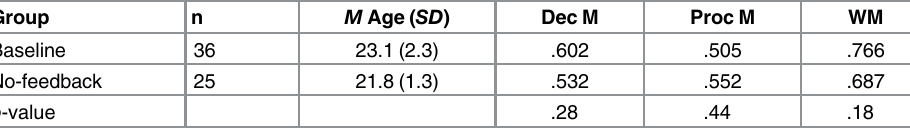
Table 3. Group sizes, mean ages, and memory measures for the baseline and no-feedback groups in Experiment 2. Bottom row shows p-values from t-tests confirming that the groups were matched on each memory measure.